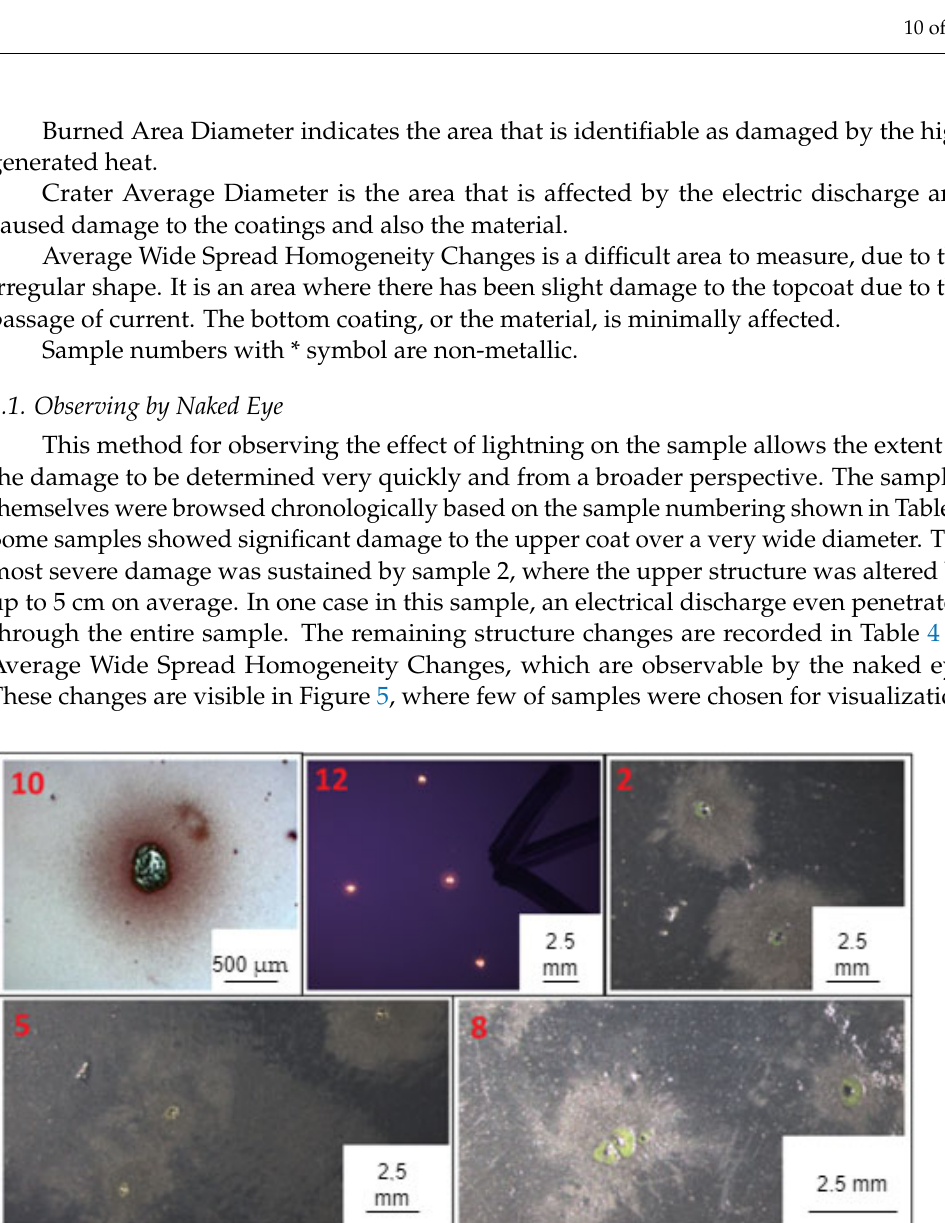
Figure 6. Damages of samples by electric discharge 1–4 (sorted following Table 3).